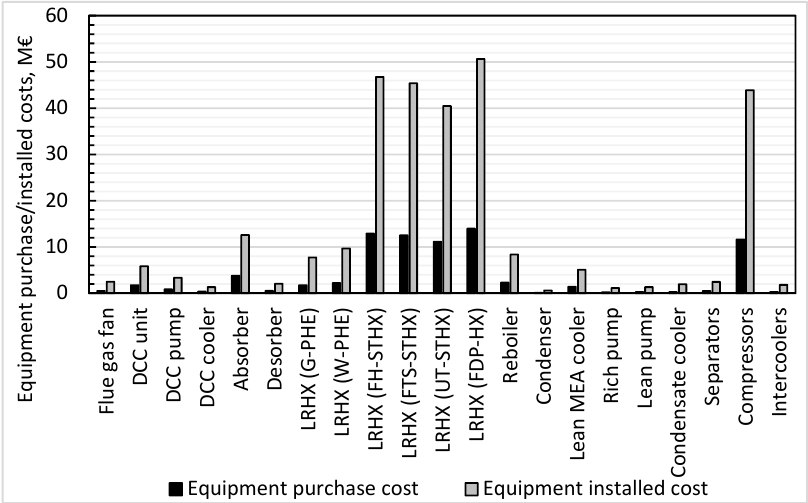
Figure 5. Equipment purchase and installed costs, including the four different types of heat exchangers. The capital cost, heat exchanger purchase costs and installed costs, the number of heat exchangers, and the proportion (%) of each heat exchanger’s contribution to the CAPEX for each capture plant scenario are presented in Figure 6. The finned double-pipe heat exchanger (FDP-HX) has the highest cost and the highest number of units. Its contribution to the CAPEX was 5% more than that of the base case scenario. The FTS-STHX and FH-STHX scenarios had contributions of 2% and 3%, respectively,